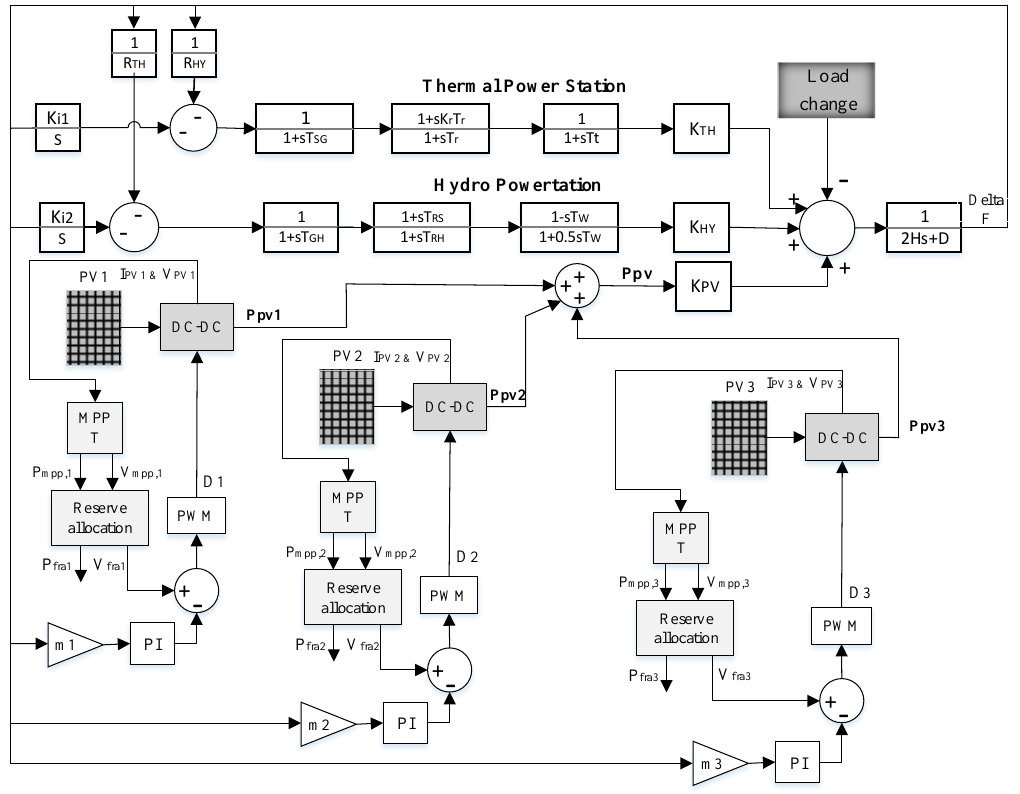
Figure 7. A linear block diagram of the photovoltaic (PV)system contributing to the frequency control.